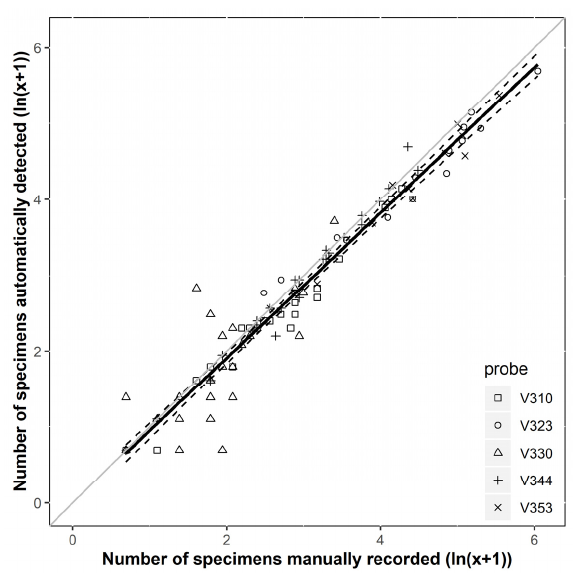
Figure 4. The relationship between the number of detections and captures of D. v. virgifera at Érd Elvira and Tordas sites using ZooLog KLP probes. One point represents the number of catches and the corresponding number of detections in a given period for a given probe. The solid line shows the predicted values from the linear model, and the broken lines show the 95% prediction interval. The solid grey line indicates the equality between the two variables. Insects 2020 , 11 , x FOR PEER REVIEW